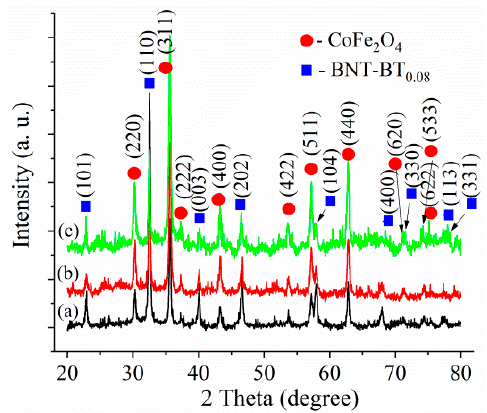
Figure 1. XRD patterns of the BNT–BT 0.08 / CoFe 2 O 4 core–shell powders: ( a ) sample S 1 , ( b ) sample S 2 , ( c ) sample S 3 calcined at 700 °C for 1 h in air.